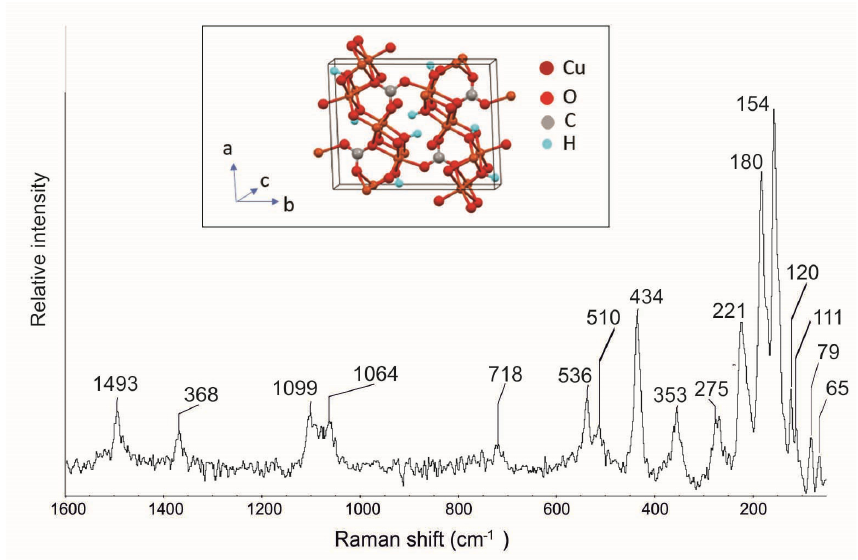
Figure 16. Raman spectrum of malachite crystals from the Mastricarro Barite Mine (Catanzaro, southern Italy). In the insert is the structure of the malachite [47].